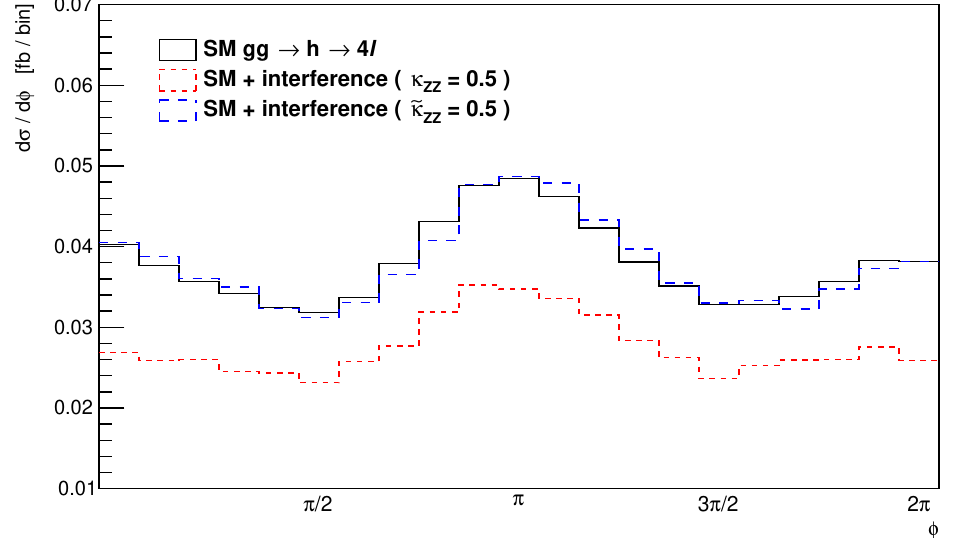
Figure 4 . Azimuthal angle φ S 0 differential distribution of the negatively-charged lepton (defined in the Higgs rest frame S 0 ) for the SM-driven gg → h → 4 ‘ process (solid black), as well as the SM + interference terms for the CP -even κ ZZ = 0 . 5 (dotted red) and CP -odd ˜ κ ZZ = 0 . 5 (dashed blue)